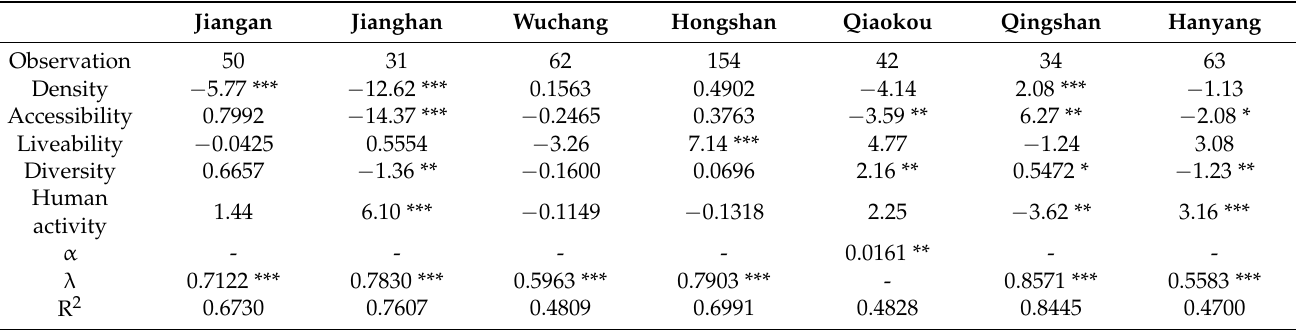
Table 3. Results of spatial regression for PM 2.5 in different